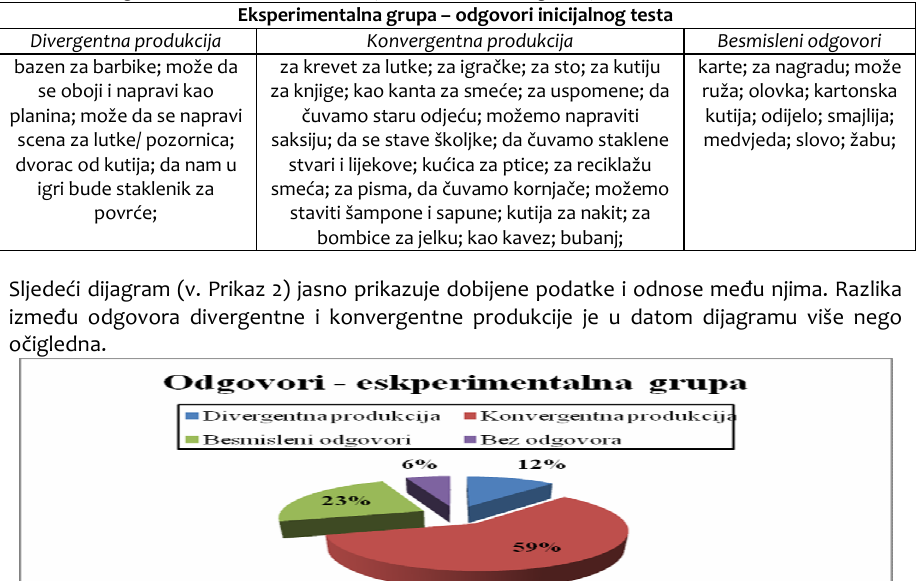
Tabela 2. Odgovori na inicijalnom testu (eksperimentalna